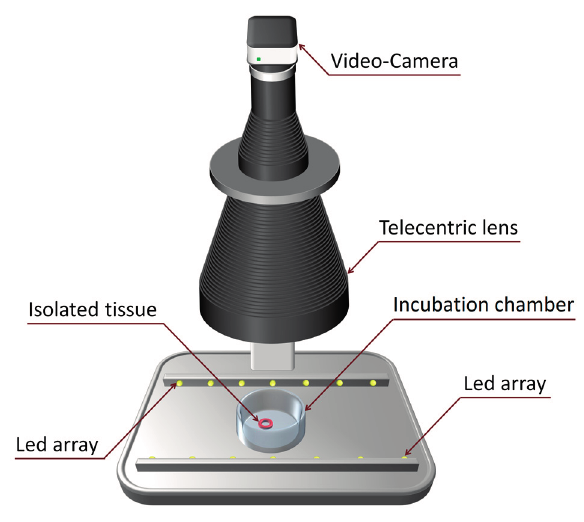
Figure 2. Image acquisition system.